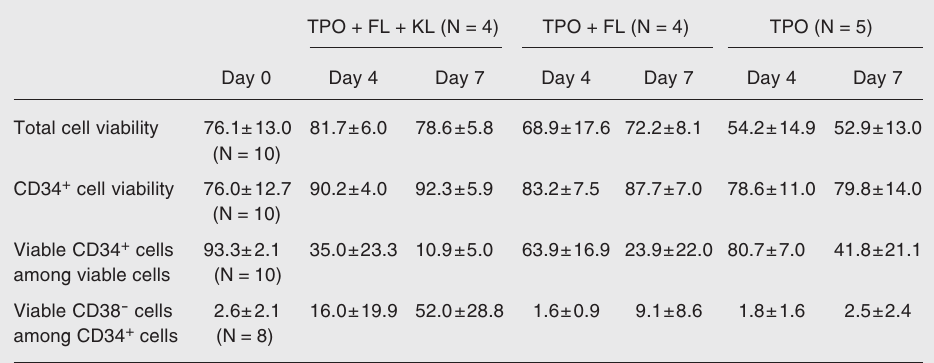
Table 2. Total and CD34 + cell viability and frequency of CD34 + and CD34 + CD38 - cells on day 0 and after culture with three different combinations of growth